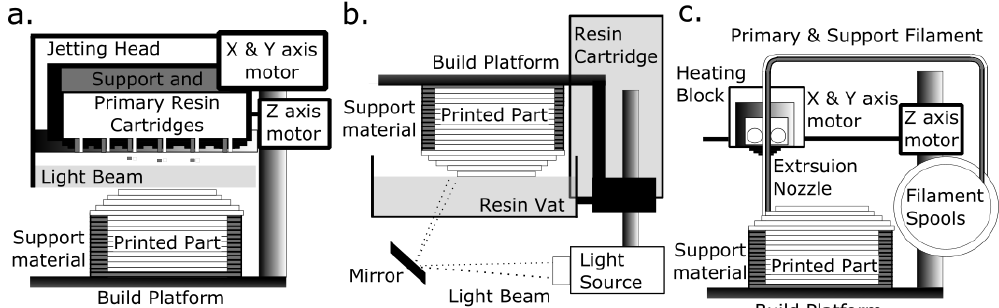
Figure 1. Examples of additive manufacturing (AM) systems that use polymer materials: ( a ) Material jetting, where a photo-sensitive photopolymer is deposited in droplets that are then polymerized by a passing light source. The process is repeated so that the solid object is built up layer by layer on the build tray. ( b ) Vat polymerization, where a photosensitive polymer contained in a vat is polymerized in a layer-by-layer fashion either by a light-beam (stereolithography and multi-photon polymerization) or by light-projection (digital light processing ). ( c ) Material extrusion, where the polymer filament is softened as it passes through a heating block and extruded in a layer-by-layer